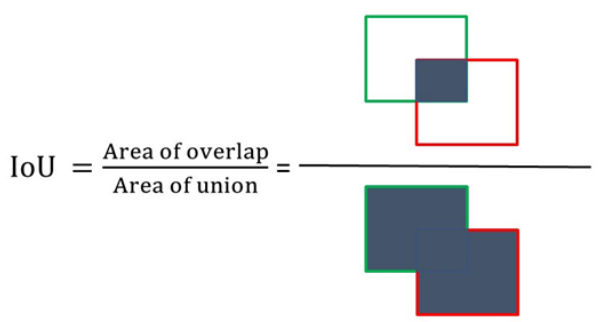
Fig. 16. Intersection Over Union